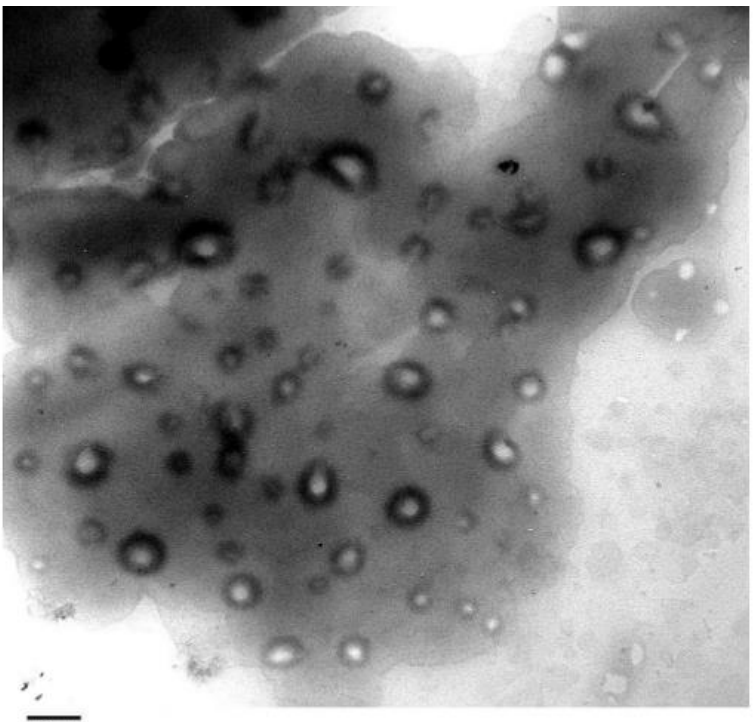
Figure 9. Transmission electron micrograph of chitosan composite transfersomes showing the outline and the core of spherical vesicles, × 20,000, scale bar 500 nm. Reproduced from Reference [156] with permission.